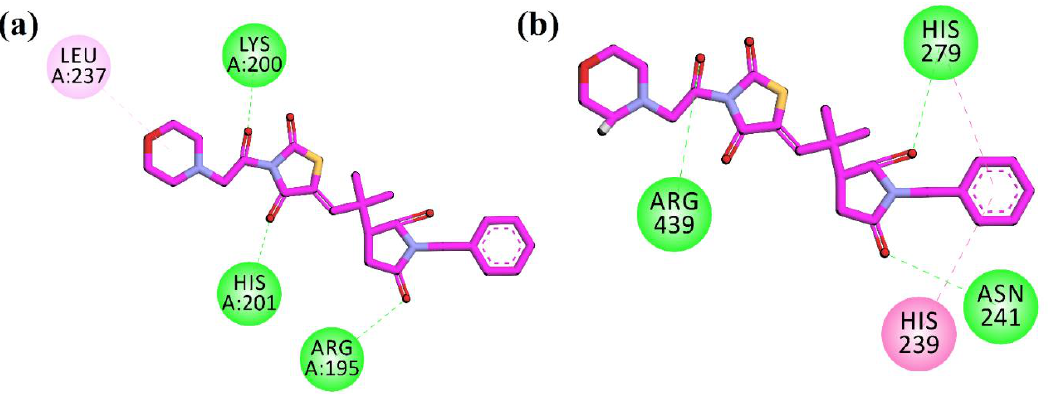
Figure 3. 2D interaction plots of 10d in the binding sites of ( a ) α -amylase (4W93) and ( b ) α -glucosidase homology model.